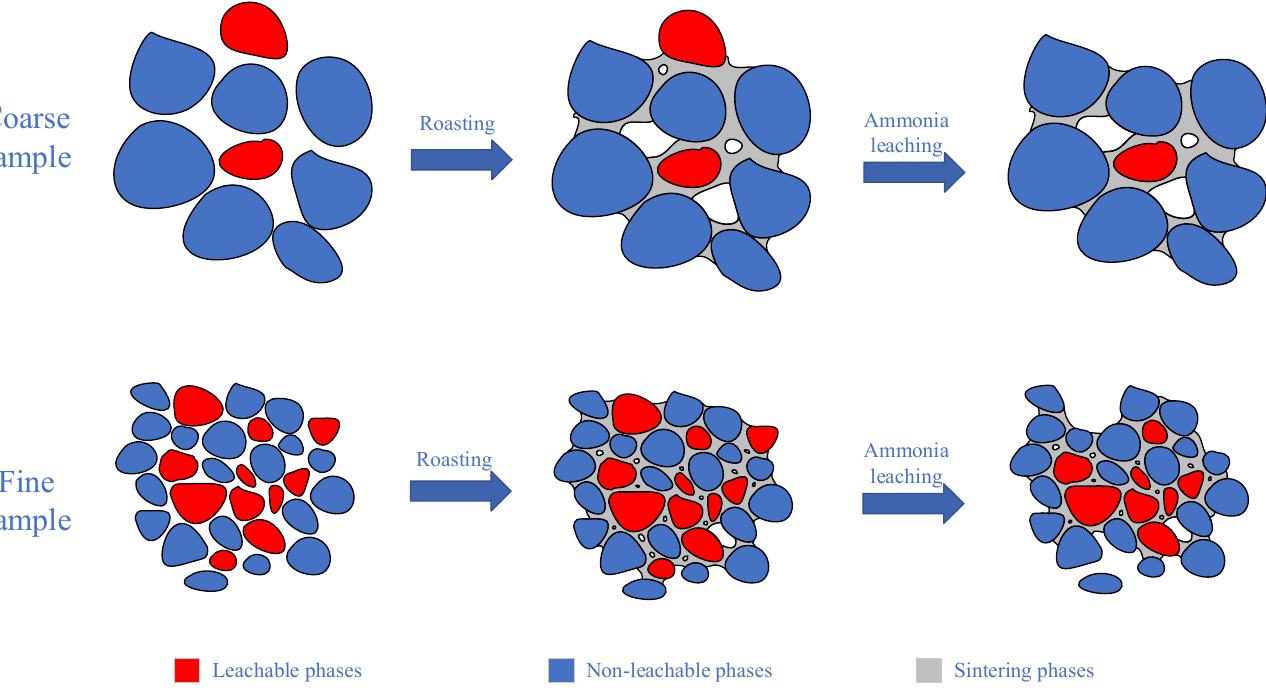
Figure 14. Leaching mechanism of phases in samples with different particle sizes during ammonia leaching process.